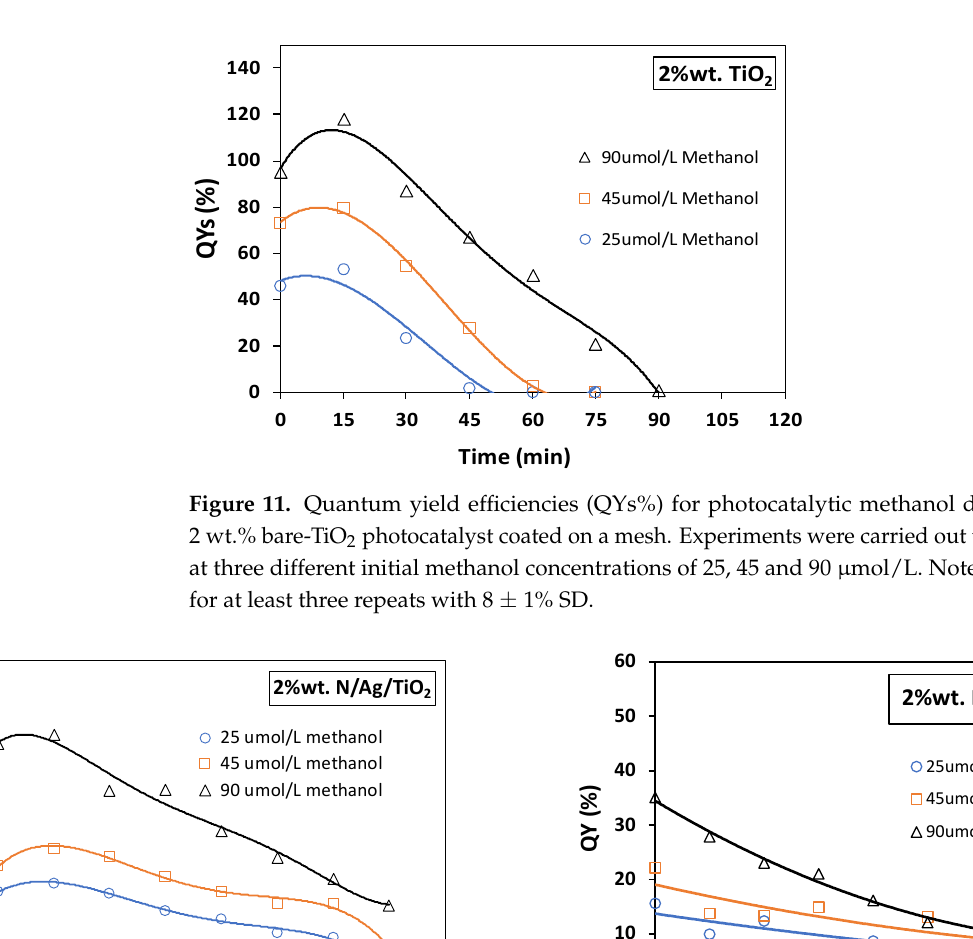
( b ) Figure 10. Photocatalytic performance of methanol degradation at three different initial concentrations of methanol (25, 45 and 90 µmol/L) with 2 wt.% N/Ag/TiO 2 coated on a mesh under ( a ) near-UV light and ( b ) visible light. Note: Reported data are for at least three repeats with 10 ± 2% SD. 3.3.4. Quantum Yield Efficiencies The quantum yield (QY) is a parameter that can be utilized to express the efficiency of the photocatalytic process (de Lasa et al., [19]). The QY can be calculated based on hydroxyl radical formation rates over the photocatalyst photon absorption rates. Figures 11 and 12 display the percentual quantum yields (QYs%), for 2 wt.% of bare-TiO 2 and N/Ag/TiO 2 coated on the mesh, as a function of irradiation reaction time for the photo- degradation of methanol at 25, 45 and 90 µmol/L concentrations. An example of a QY% calculation is described in Appendix C. Figure 11 reports QYs% for the bare-TiO 2 under near-UV light irradiation, showing a